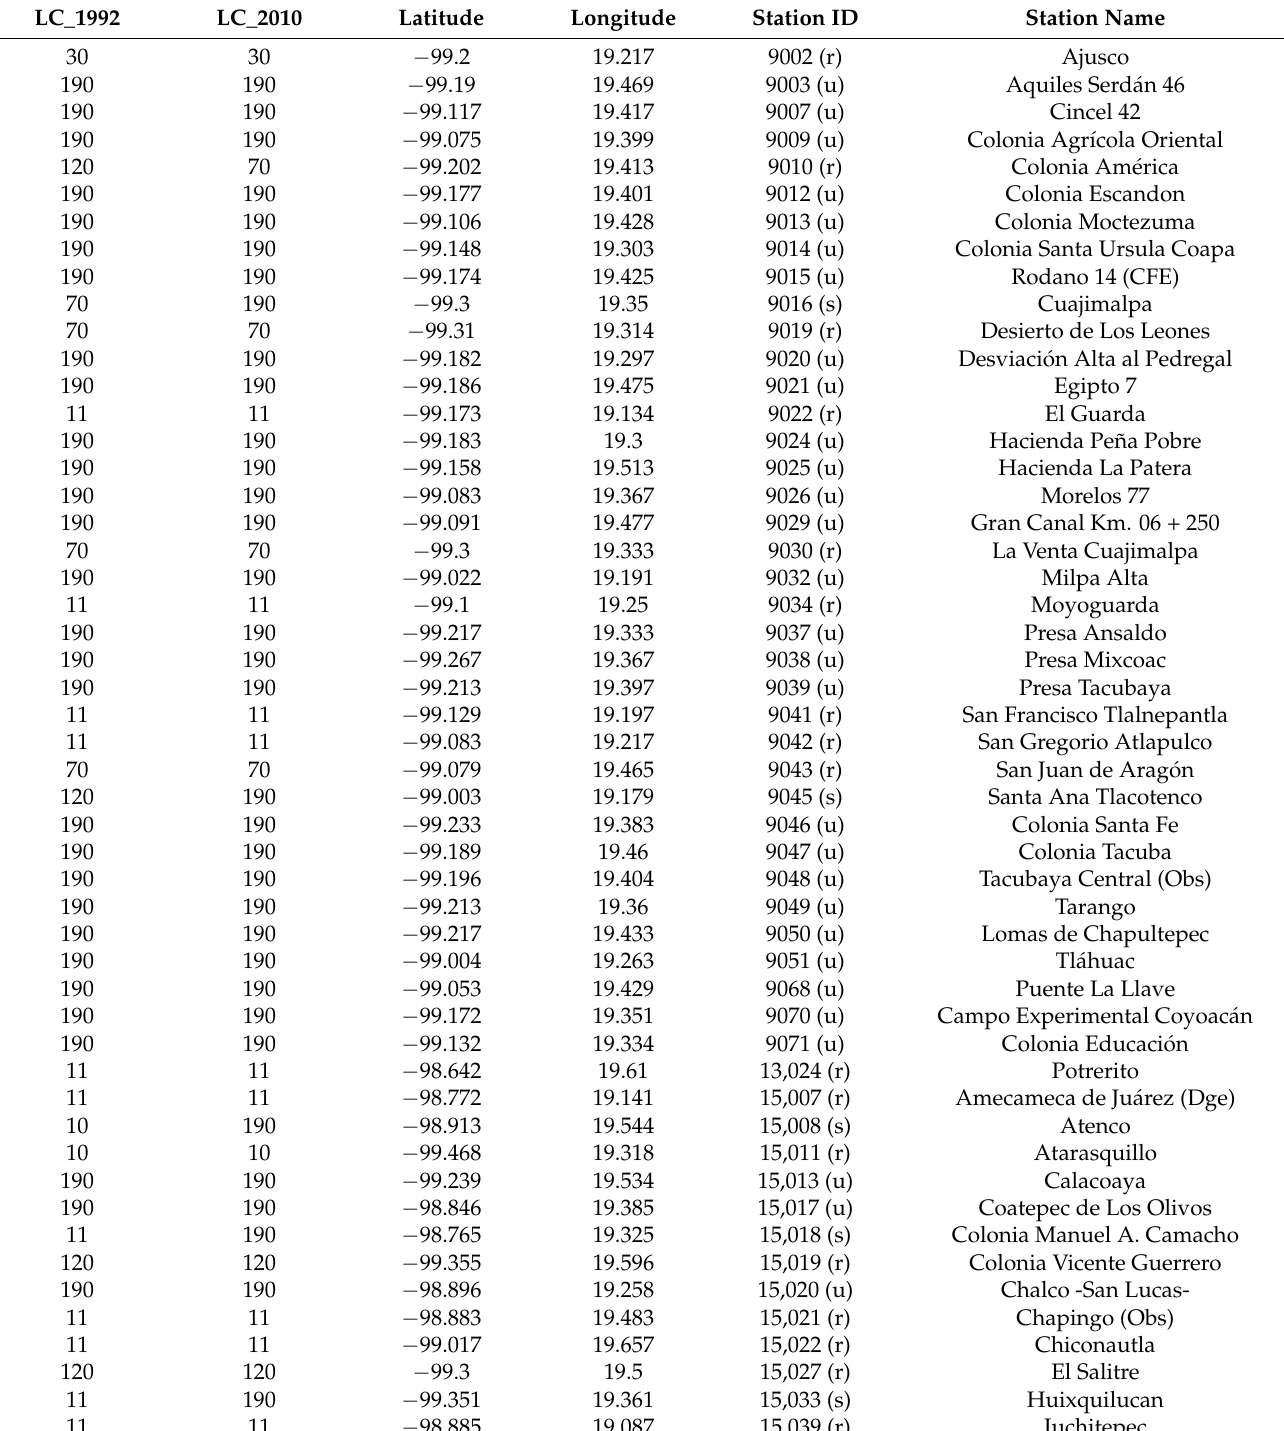
Table 1. Land-cover category in the years 1992 (LC_1992) and 2010 (LC_2010), geographical coordi- nates (Latitude and Longitude, in degrees), station identification number (Station ID), and station name of the 90 final climatological stations that were used for homogenization. The value 190 corre- sponds to urban land cover. The stations were classified as urban (u), suburban (s), and rural (r), next to the Station ID. See the other classification numbers in Table